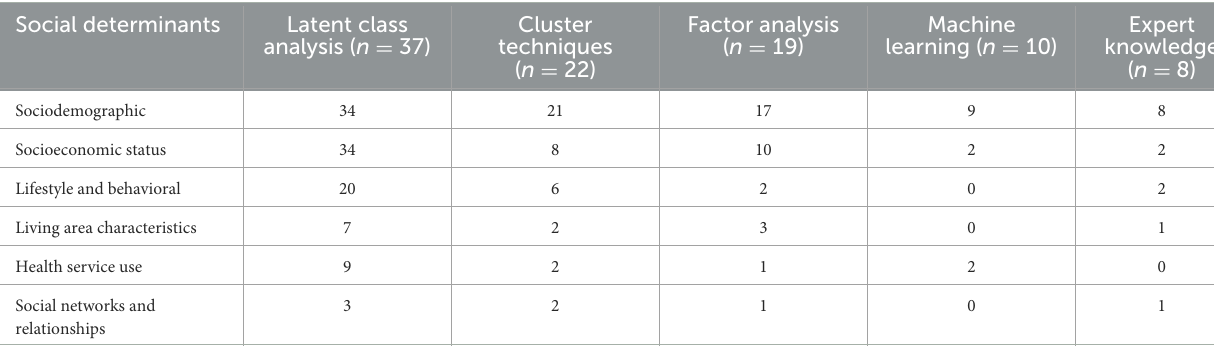
TABLE 1 Social determinants by multimorbidity pattern extraction